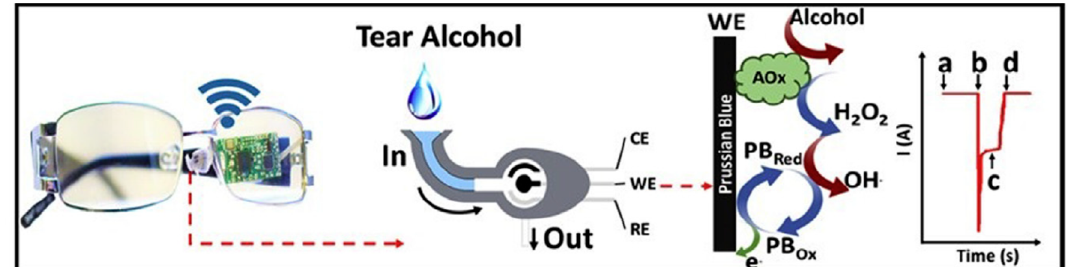
Figure 16. Eyeglasses-based tear sensing system: photo and schematic illustration of the eyeglasses platform consisting of the fluidic device and wireless electronics. A sketch showing enzymatic alcohol detection and signal transduction: ( a ) the baseline of the electrochemical biosensor; ( b ) the current change of the sensor due to the captured tear; ( c ) the measured alcohol signal by the sensor and ( d ) the signal after drying of the sensor. Reproduced from reference [112] with permission from Elsevier.